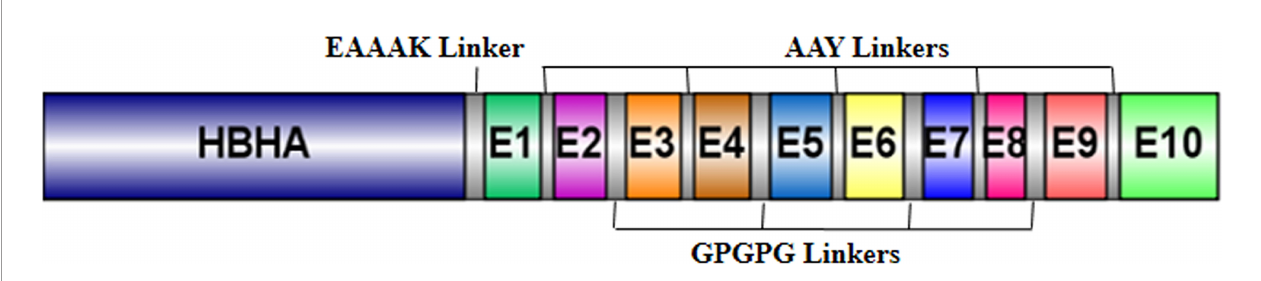
FIGURE 2 | Schematic diagram of the multi-epitope vaccine construct.